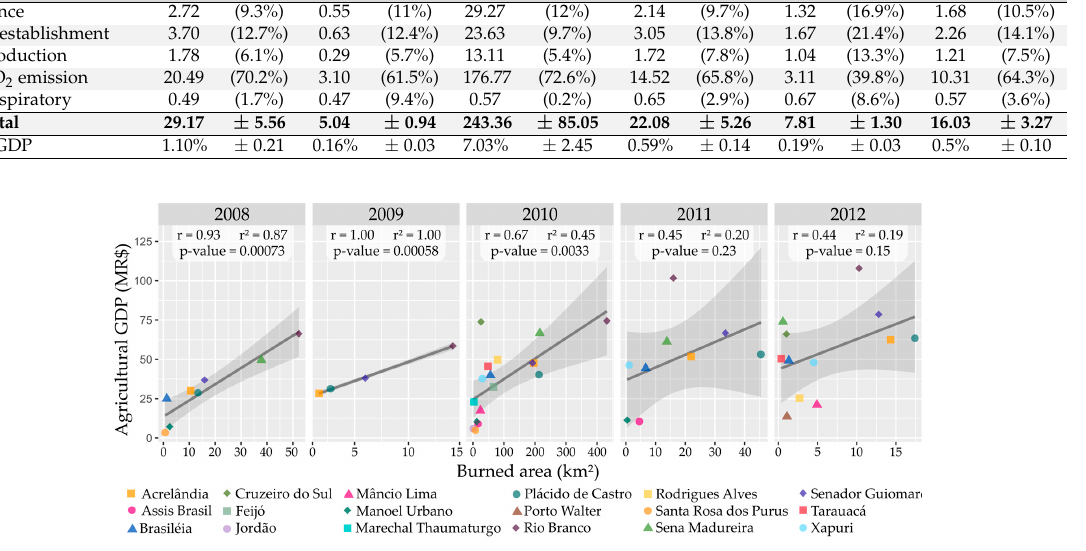
Figure A2. Correlation between GDP of the agricultural sector and burned area.